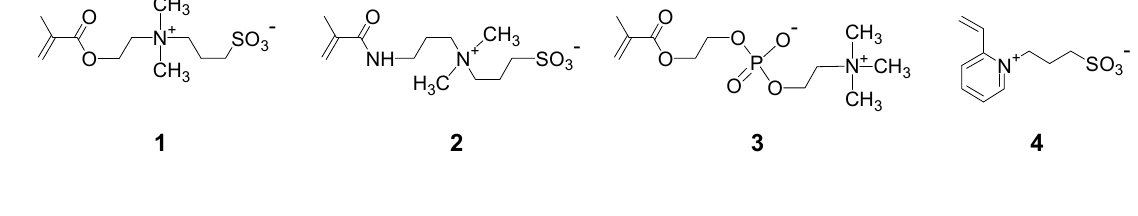
Figure 2. Chemical formula of the most widely employed and commercially available zwitter- ionic monomers (from left to right): N -(2-methacryloyloxy)ethyl- N,N -dimethyl- ammonio propanesulfonate ( 1 , “SPE”), N -(3-methacryloylimino)propyl- N,N